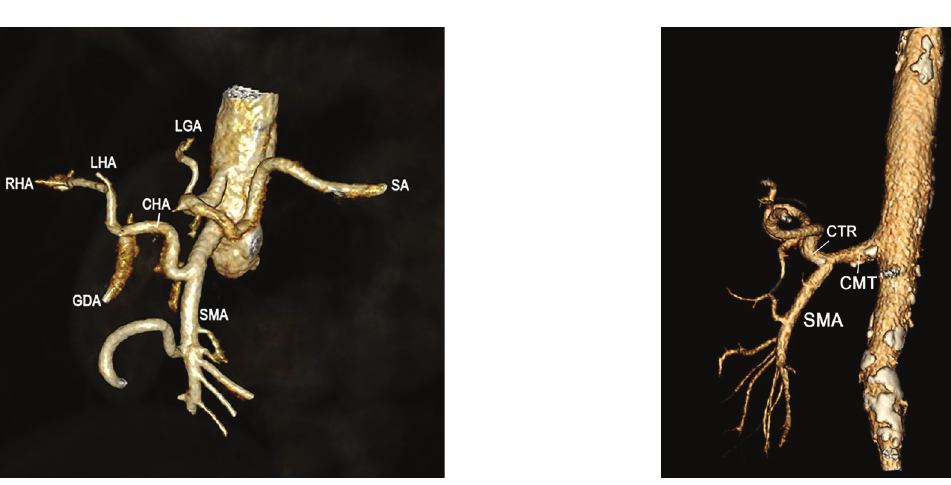
Figure 4 - Coronal CTA image shows a replaced left HA from LGA origin.